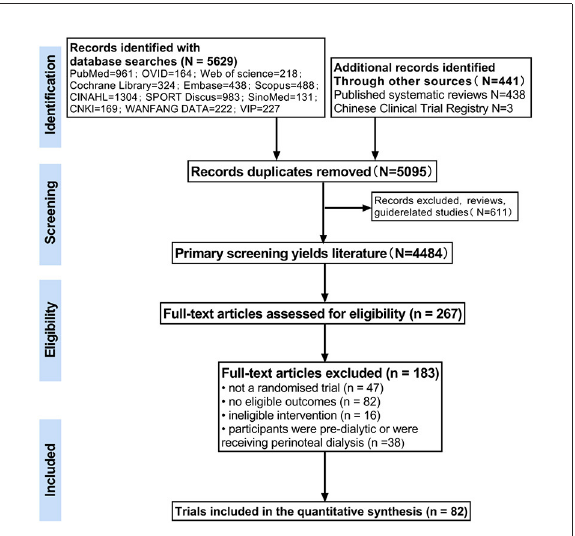
FIGURE1 PRISMA flow diagram chart for systematic review and network meta-analysis.